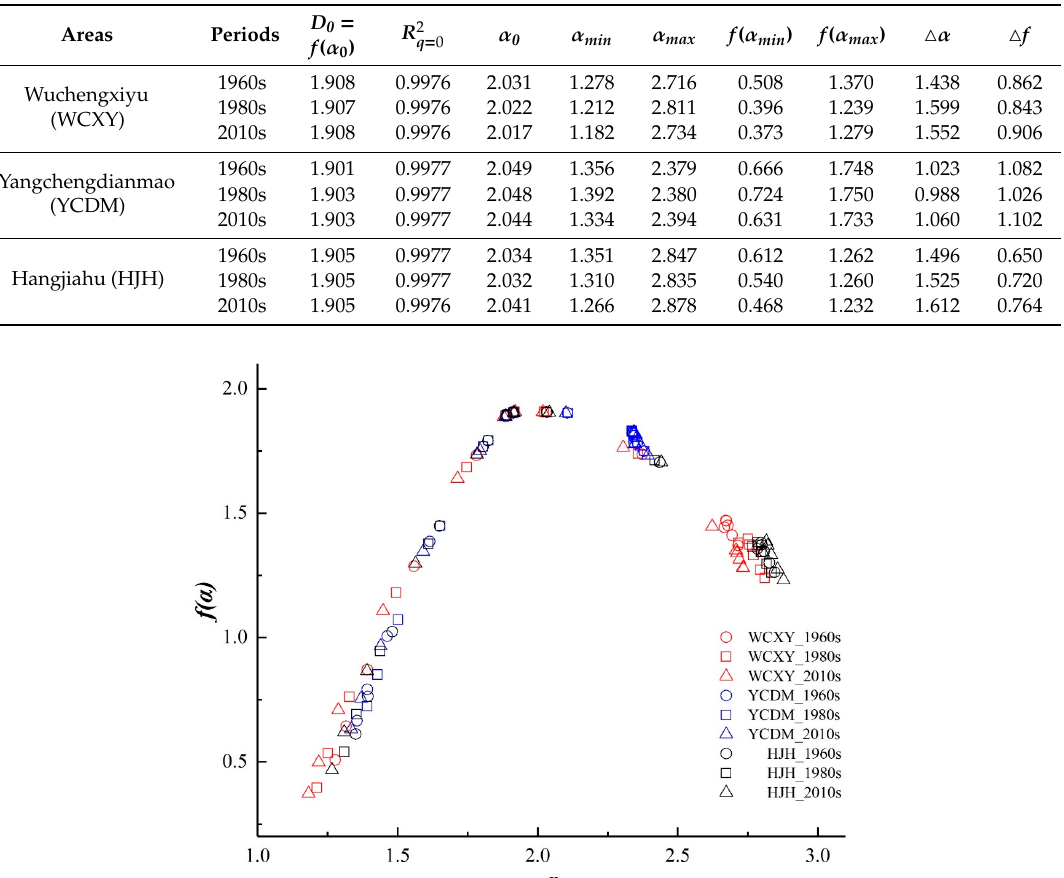
Table 2. Multifractal characteristics of study areas in different periods.